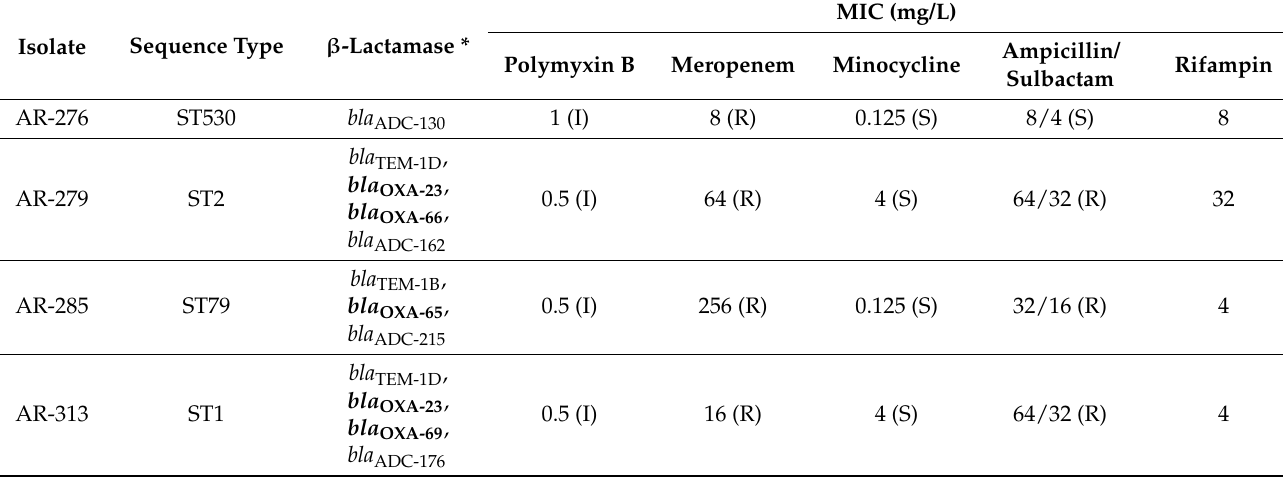
Table 1. Genotypic characteristics of CRAB isolates and their MICs for antibiotics used in time-kill assays. Interpretations of MICs are provided in